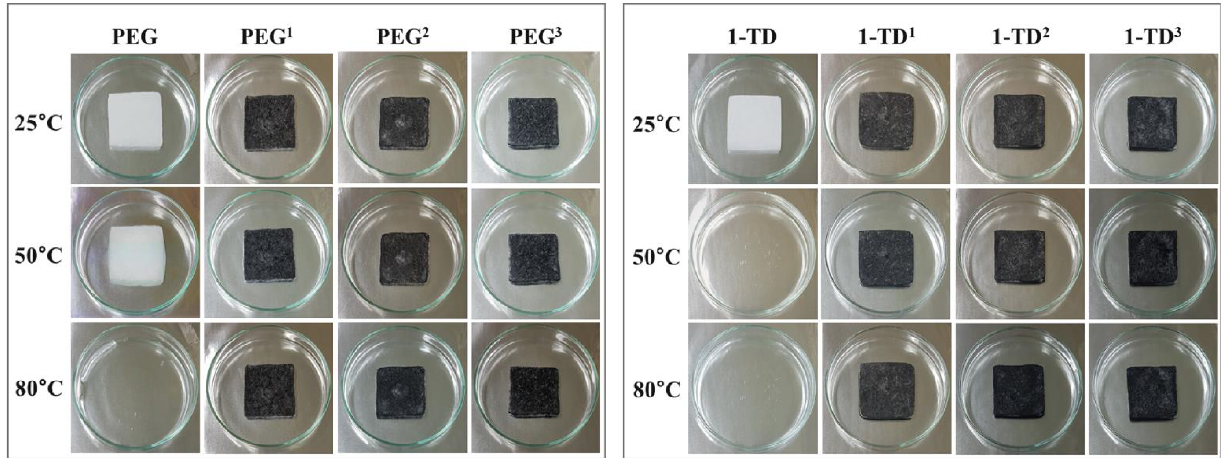
Figure 4. Photographs for the PCMs form-stable test. PEG 1 has a 2:1 ratio of rGO/GNP, PEG 2 has a 1:1 ratio and PEG 3 has a 1:2 ratio. 1-TD composites are labeled in the same way.